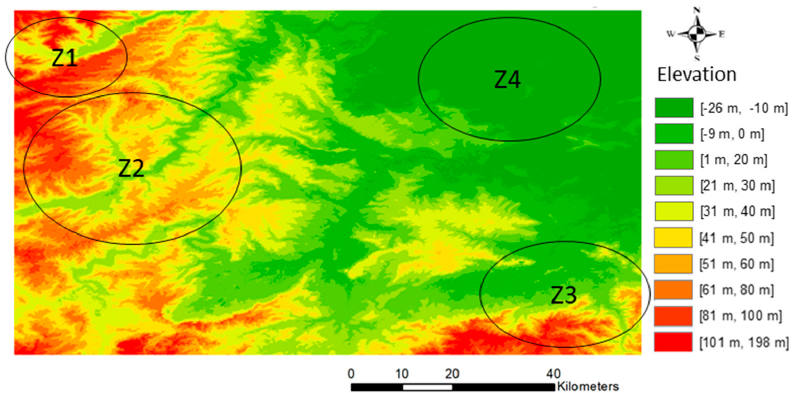
Figure 18. The Ordnance Survey reference drainage network ( a ), the drainage network extracted from the original SRTM 30 ( b ), from the rebuilt DEM using OSM rivers and streams ( c ), and from the rebuilt DEM using only the rivers ( d ).